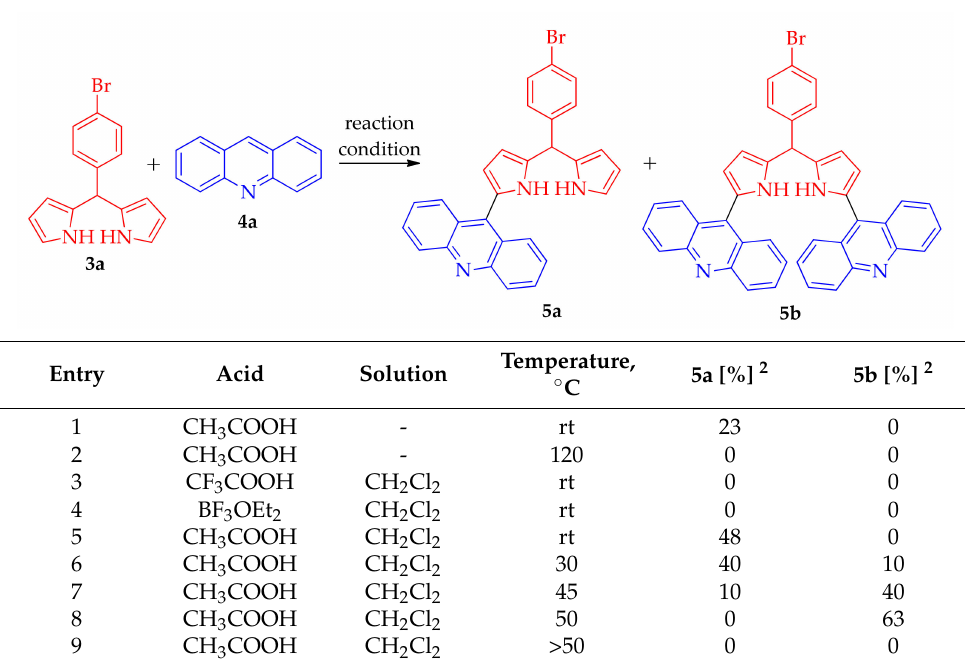
Table 1. Optimization of reaction conditions 1